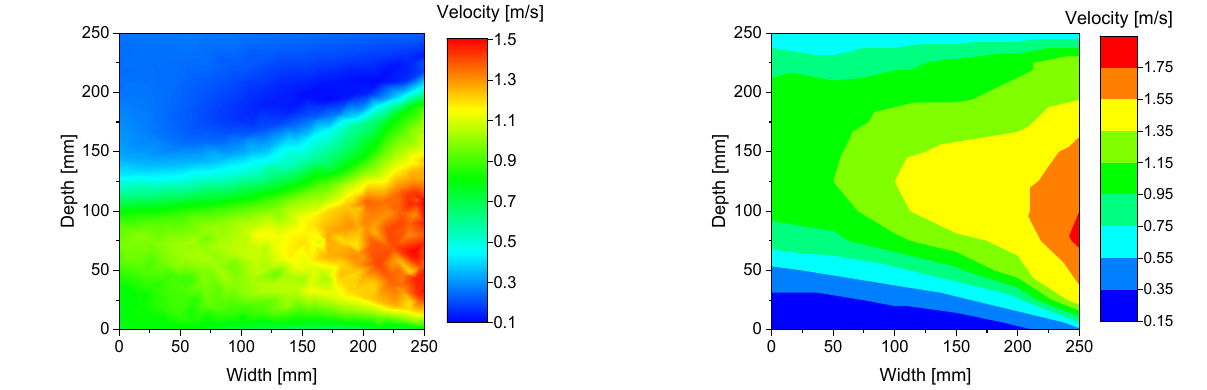
Figure 3. Velocity contour in the center plane (XZ plane at a height of 67.5 mm above build plate). ( Left ): Simulated velocity profiles using realizable k- ε turbulence model. ( Right ): Experimental velocity measurements. Volume flow rate: 250 LPM, gas: air.